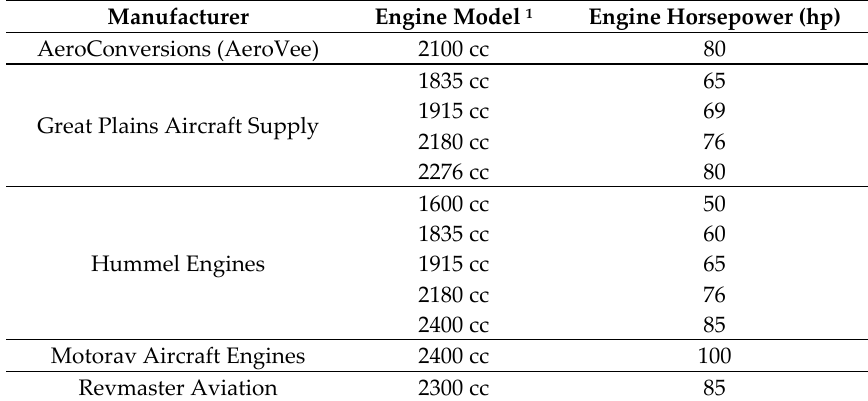
Table 1. List of Volkswagen conversion engine models and suppliers